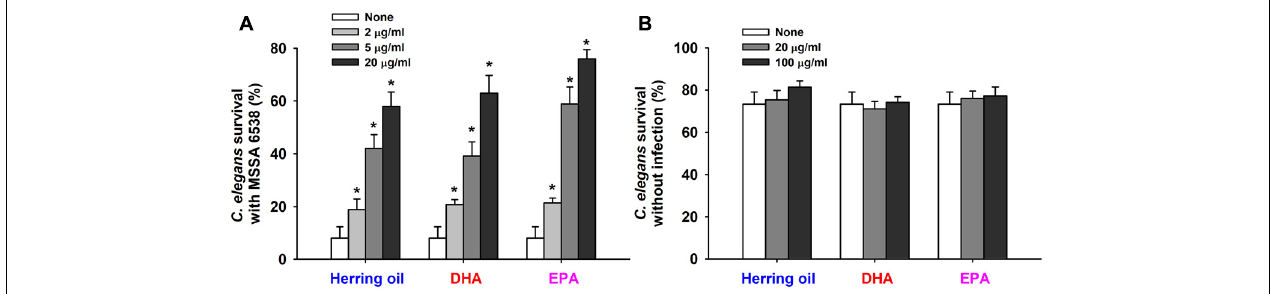
FIGURE 5 | Effects of herring oil, DHA, and EPA on nematode survival. C. elegans fer-15;fem-1 strain survival after infection with S. aureus MSSA 6538 in the presence of DHA, EPA, or herring oil (2, 5, or 20 µ g/ml) after exposure for 1 day at 25 ◦ C (A) . Herring oil, DHA, and EPA toxicities were assessed by determining survival rates versus non-infected nematodes (B) . Survival was assessed as dead or alive based on movement. ∗ p < 0.05 versus non-treated controls.